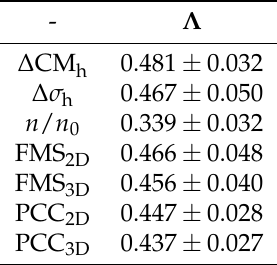
Table 1. The exponent Λ (day − 1 ) and the error of the exponential fits to the curves ∆ CM h , ∆ σ h , n / n 0 , FMS 2D , FMS 3D , PCC 2D and PCC 3D versus ∆ t b of the case study in Figures 5 and